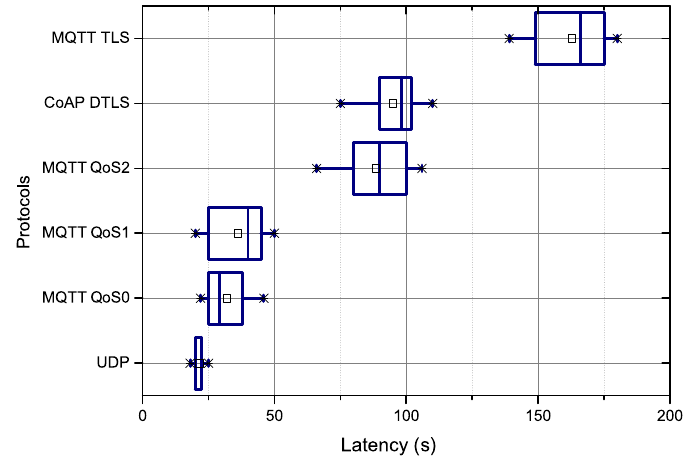
Figure 13. Link latency of the consumer– aggregator communication with the tested